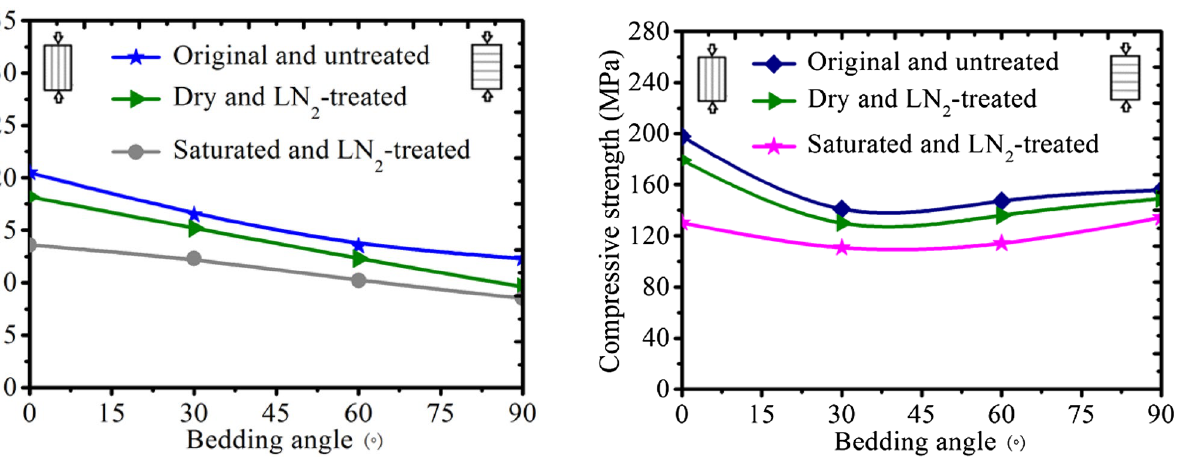
Fig. 8 Compressive strength of different bedding shales before and after LN 2